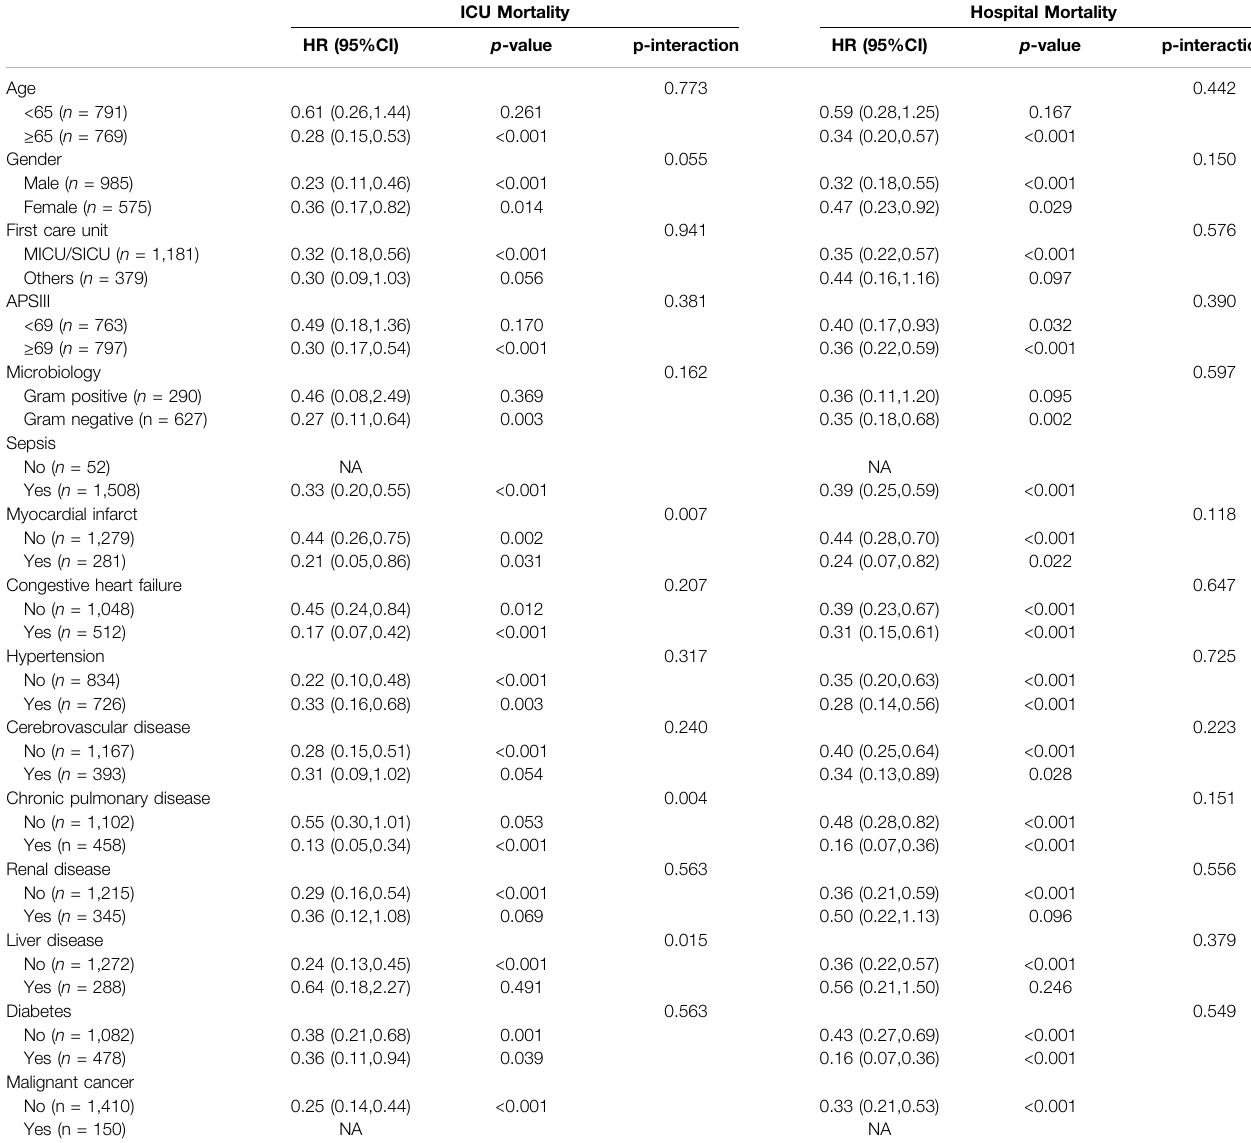
TABLE 3 | Subgroup analysis of relationship between groups and mortality. ICU Mortality Hospital